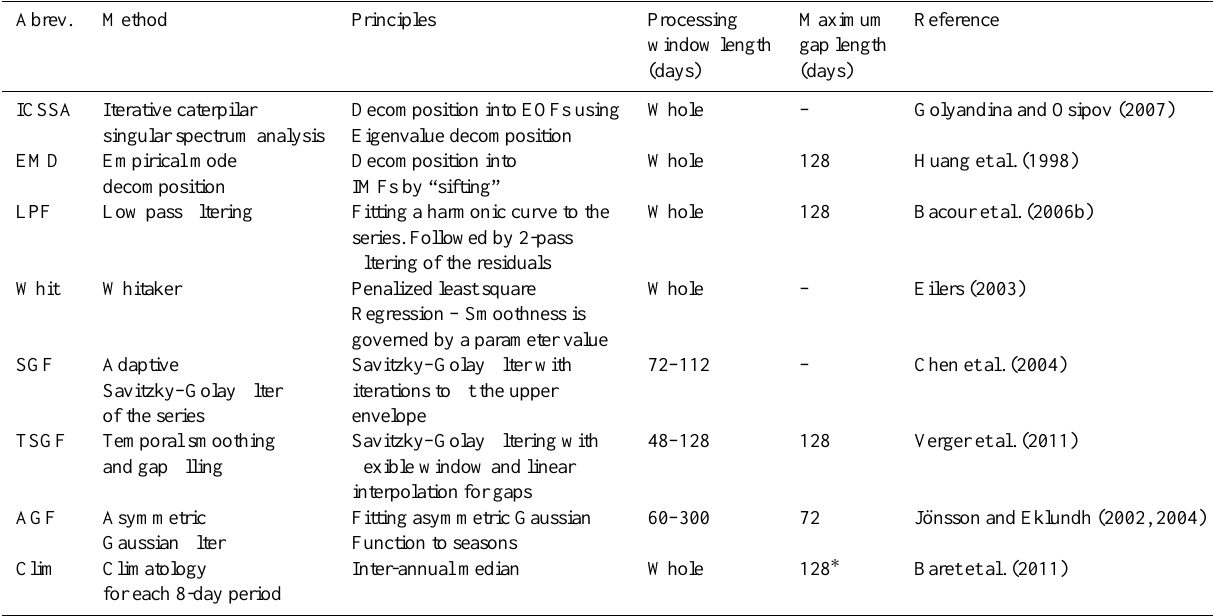
Table 1. List of the methods investigated. Length of processing window (whole means that the processing window is the whole time series) and maximum gap length tolerated are indicated.